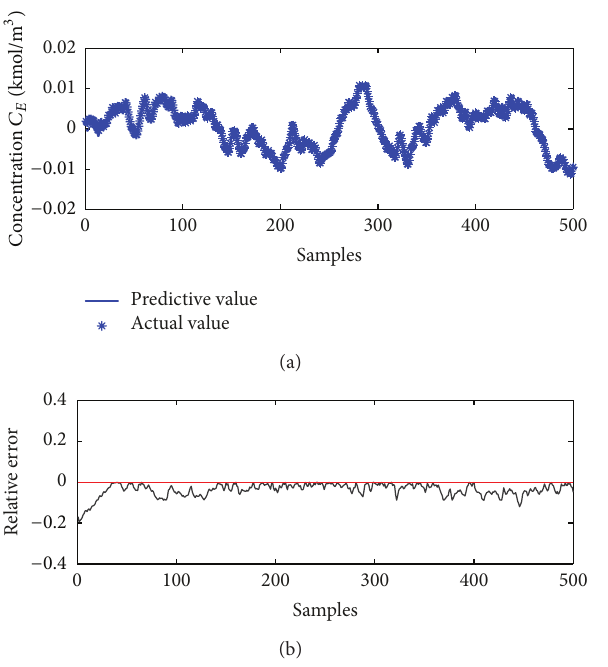
Figure 6: Biodiesel concentration prediction result and relative error under reactor flow rate 𝐹 𝑐 action.